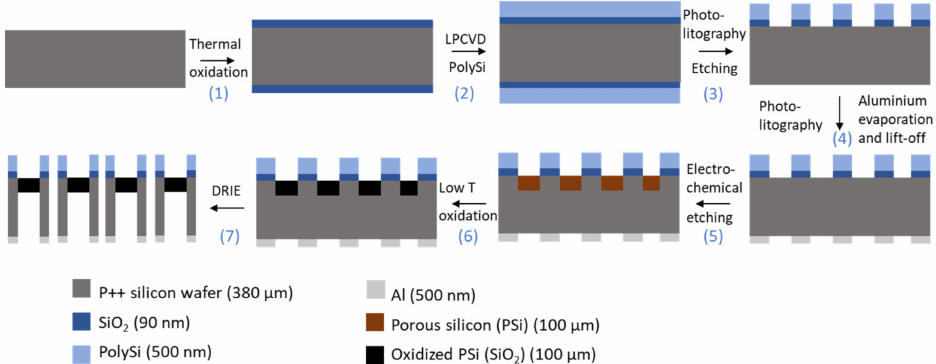
Figure 1. Schematic illustration of the manufacturing process of PSi membranes. Starting from